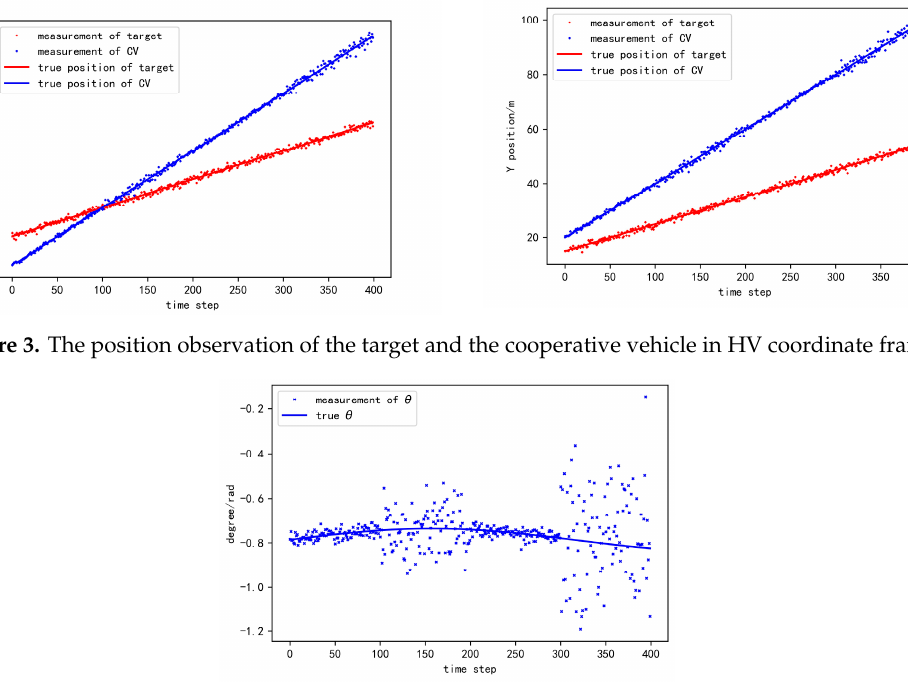
Figure 4. The heading angle observation of the cooperative vehicle in HV coordinate frame.